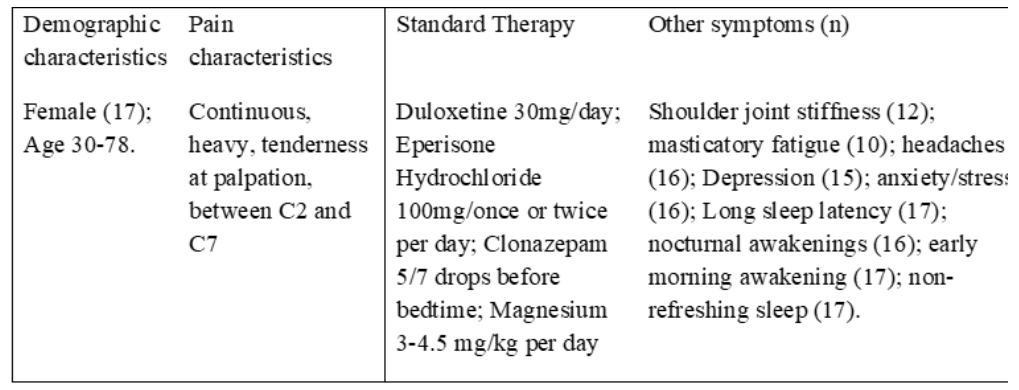
Figure 2. General characteristics of the included individuals.